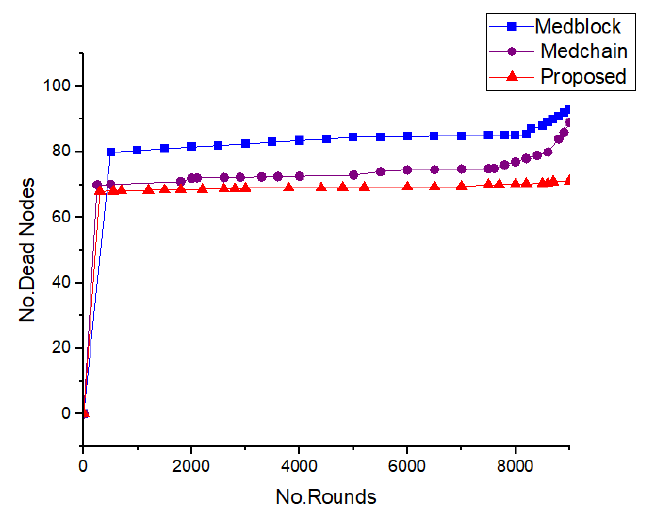
Figure 13. Comparative analysis of our proposed framework vs. the benchmark models [50,51] considering the attributes of dead nodes versus the total number of rounds (0, 9000).